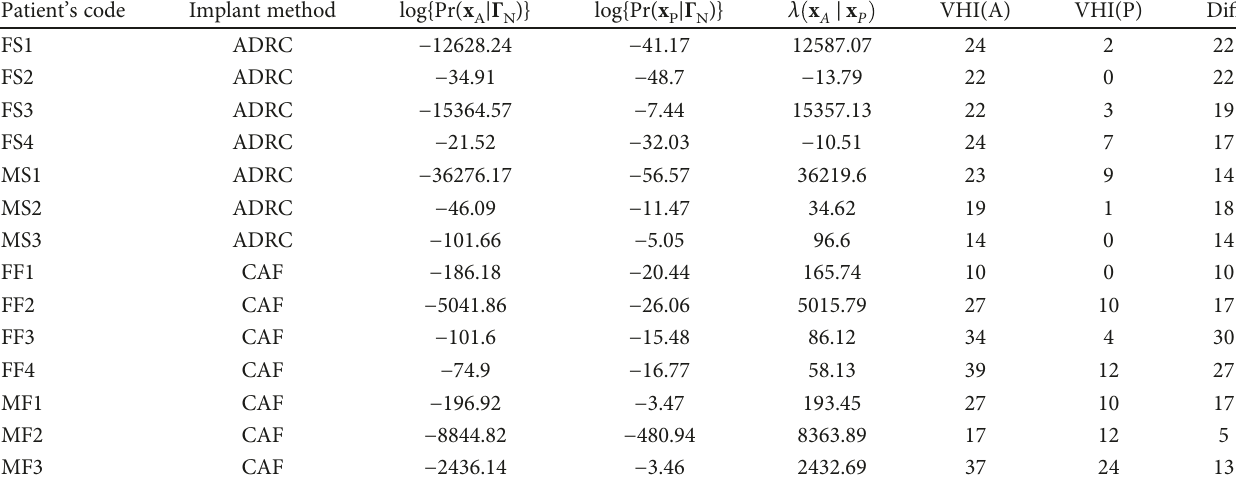
Table 7: Voice quality improvement from likelihood ratios and VHI.